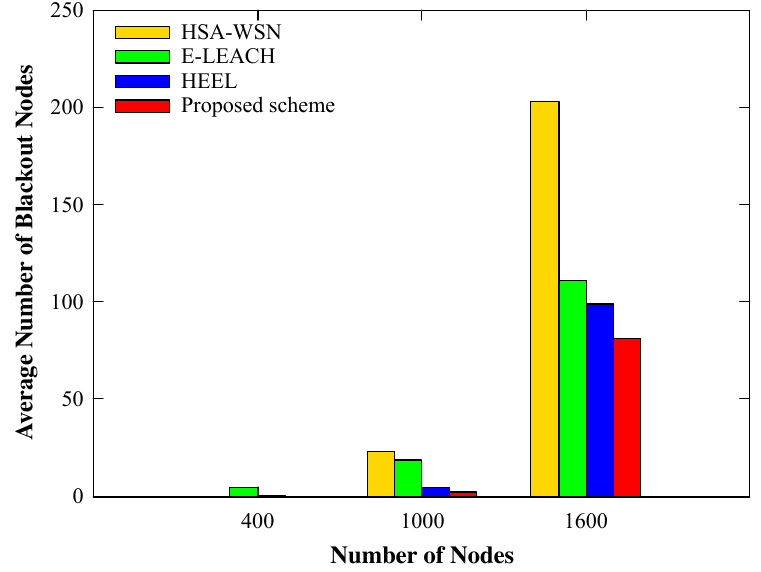
Figure 9. The number of blackout nodes according to the number of